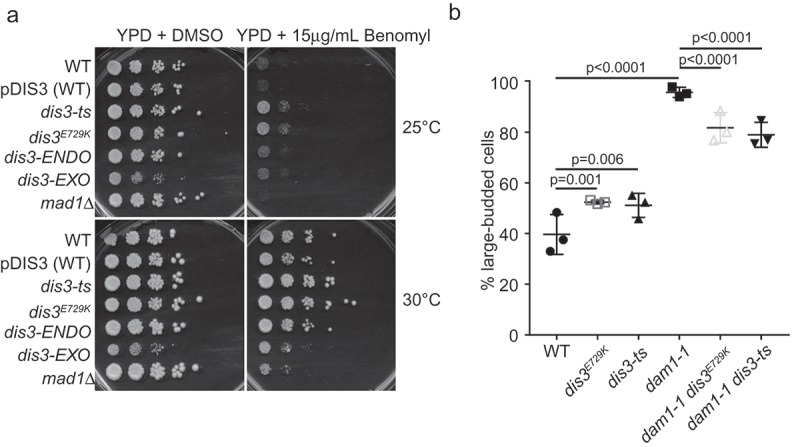
Mitosis-associated defects in DIS3 mutants. (a) Spot dilution assays of the indicated alleles on plates with microtubule depolymerizer benomyl. (b) Budding index measurements of the indicated mutants show suppression of dam1-1 G2/M arrest after a 3 hour temperature shift to 37°C by dis3E729K or dis3-ts. The Holm-Bonferroni corrected p-value determined by a Fisher Exact test is shown above each relevant comparison.